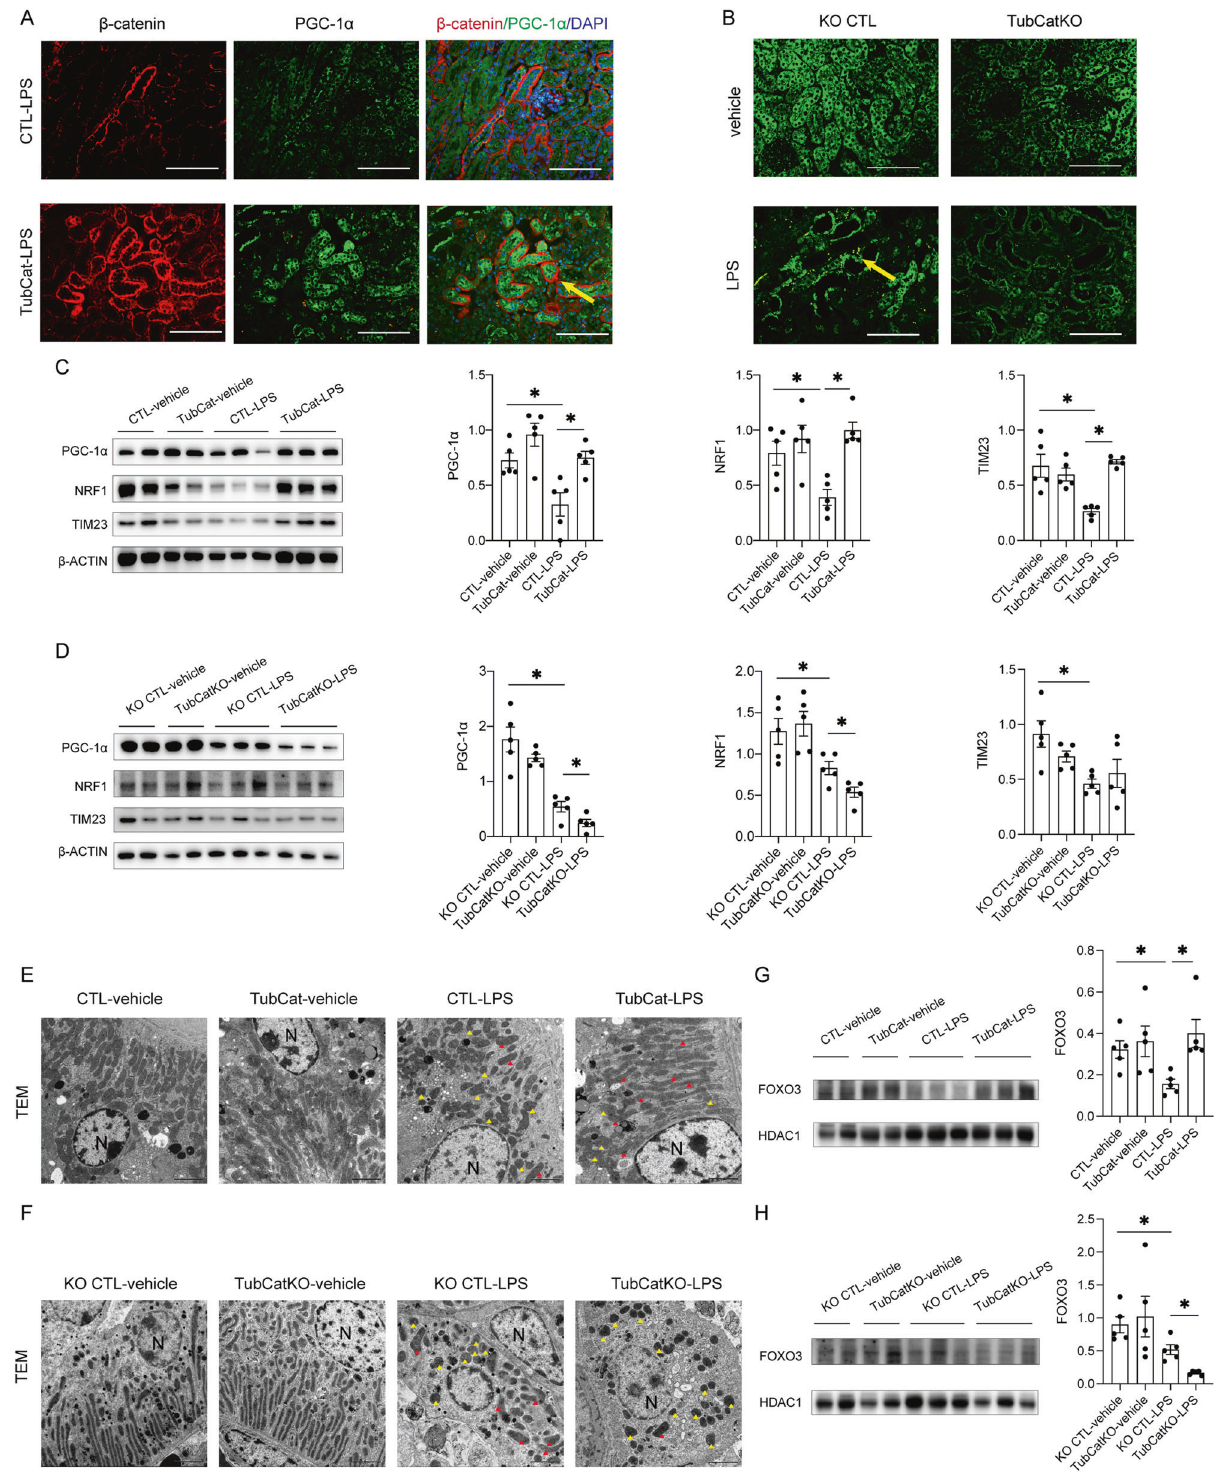
related protein 1 (DRP1) is a GTPase that controls mitochondrial fi ssion. Mitochondrial dynamics shifts towards fi ssion during IRI with downregulation of fusion regulators OPA1 and MFN2, but upregulation of fi ssion regulator DRP1 (Fig. 7). In TubCat-IRI kidneys, markedly reduced OPA1 and MFN2 was restored, and DRP1 overexpression was suppressed vs. CTL-IRI kidneys (Fig. 7A). Conversely, TubCatKO-IRI kidneys had further reduction of OPA1